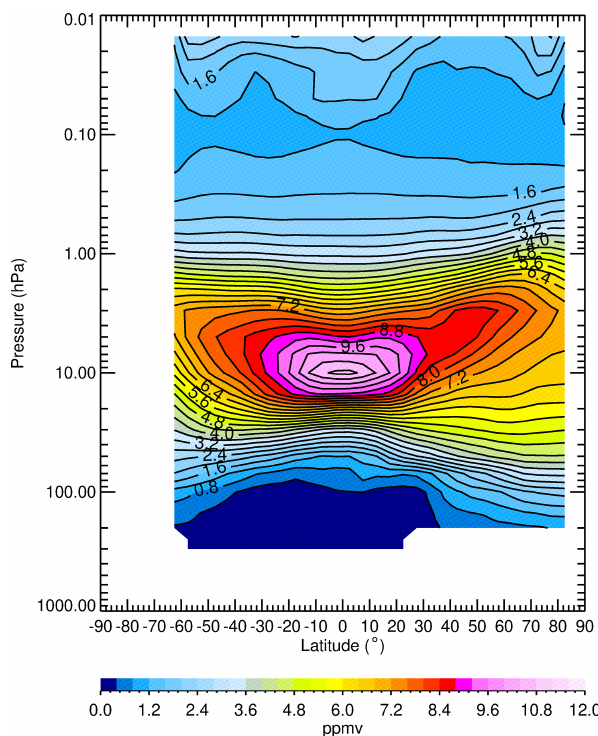
Figure 1. Zonal average ozone for March 1979 from the combina- tion of the LIMS V6 ascending and descending orbital data. Contour interval (CI) is